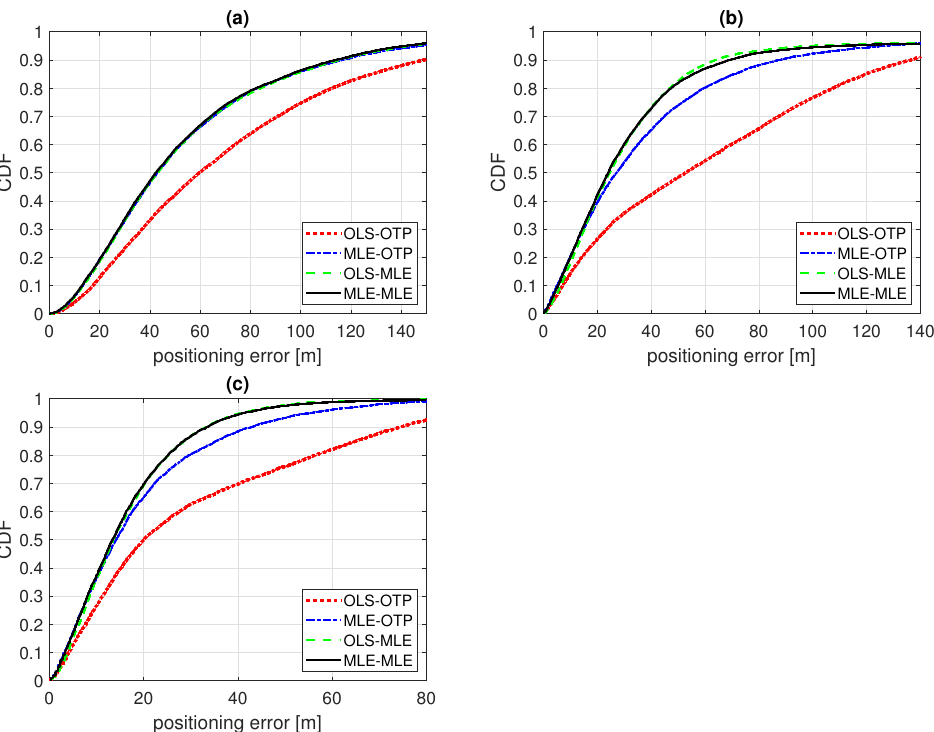
Figure 7. CDF of positioning error of Example 1. Model fitting to training data with ordinary least squares (OLS-) or Tobit MLE fitting (MLE-) and positioning with either ordinary trilateration (-OTP) of Tobit MLE positioning (-MLE). ( a ) N = 1, N BS = 2; ( b ) N = 8, N BS = 2; ( c ) N = 8, N BS =